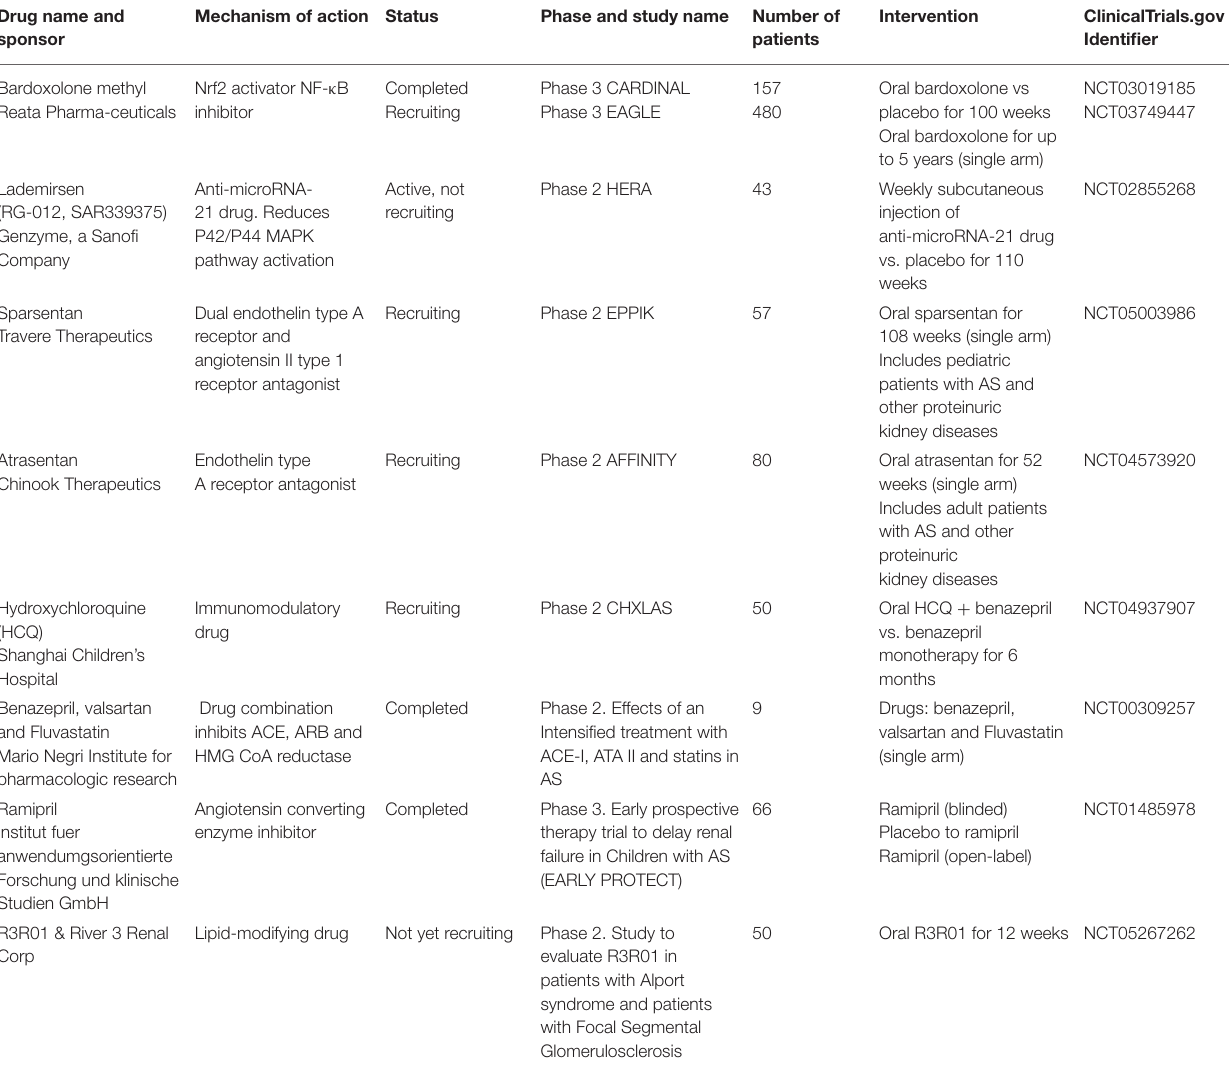
TABLE 2 | Clinical trials for Alport Syndrome listed on